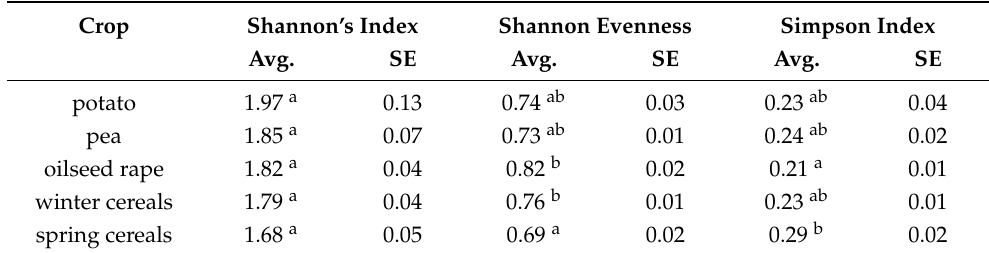
Table 4. Species diversity indices crops. Average values (avg.) ± standard error (SE) was assessed over years, treatments and localities. The averages marked by the same letter in individual columns did not significantly differ at α = 0.05 (Scheffe’s test).